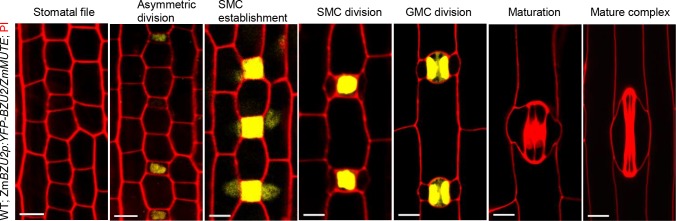
BZU2/ZmMUTE is specifically expressed in the guard mother cell and the subsidiary mother cell establishment stage during stomatal development in maize.BZU2/ZmMUTEp:YFP-BZU2/ZmMUTE expression in wild type during stomatal development. YFP-BZU2/ZmMUTE is expressed from young GMCs to mature GMCs, and demonstrates a particularly strong signal in mature GMCs and at the SMC establishment stage. Expression of YFP-BZU2/ZmMUTE disappears during stomatal complex maturation after GMC division. These images were observed using the second or third leaf, 4 to 5 dag, of the T1 generation. Propidium iodide (red) was employed to counterstain the cell walls. Scale bars, 10 μm. dag, days after germination.